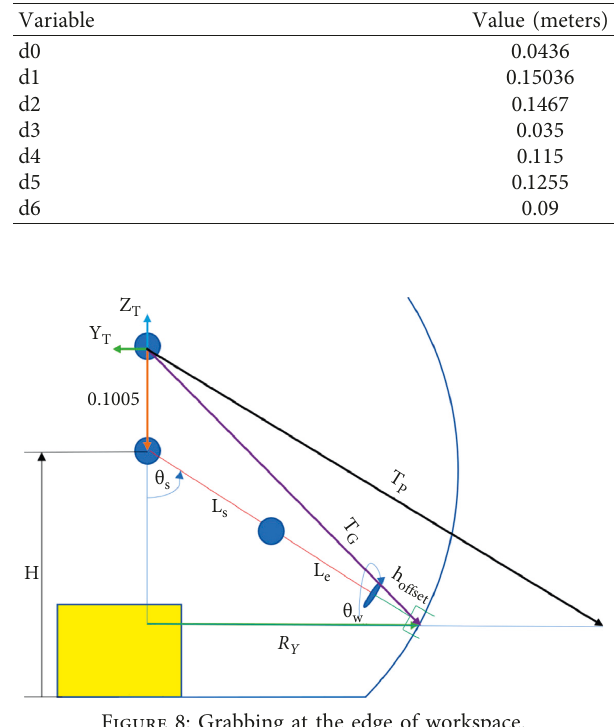
Figure 8: Grabbing at the edge of workspace.